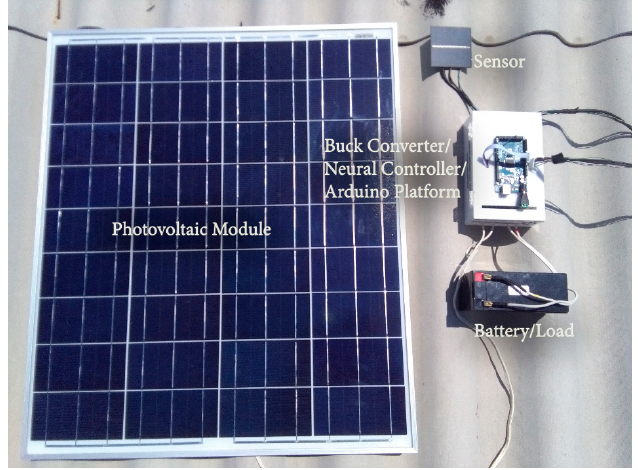
Figure 17. PV system hardware.